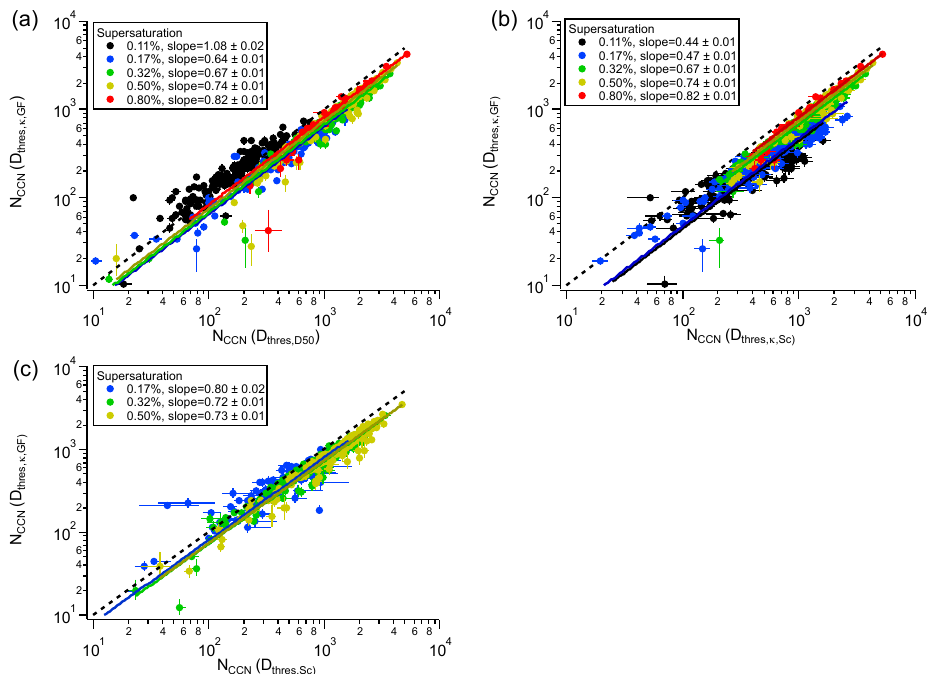
Fig. 7. The number of cloud condensation nuclei ( N CCN ) as predicted from HTDMA derived κ -K¨ohler analysis plotted against (a) N CCN derived from D-step ( D 50 , S ) analysis, (b) N CCN derived from κ S analysis, (c) N CCN derived from S-step ( S c ,D ) analysis. Where possible, c 0 the calculations were preformed for the five supersaturation settings. The error bars are the upper and lower bounds in N CCN given as a result of the propagation of errors through the analysis procedure. The best fit lines have been plotted using orthogonal distance regression and are weighted according to